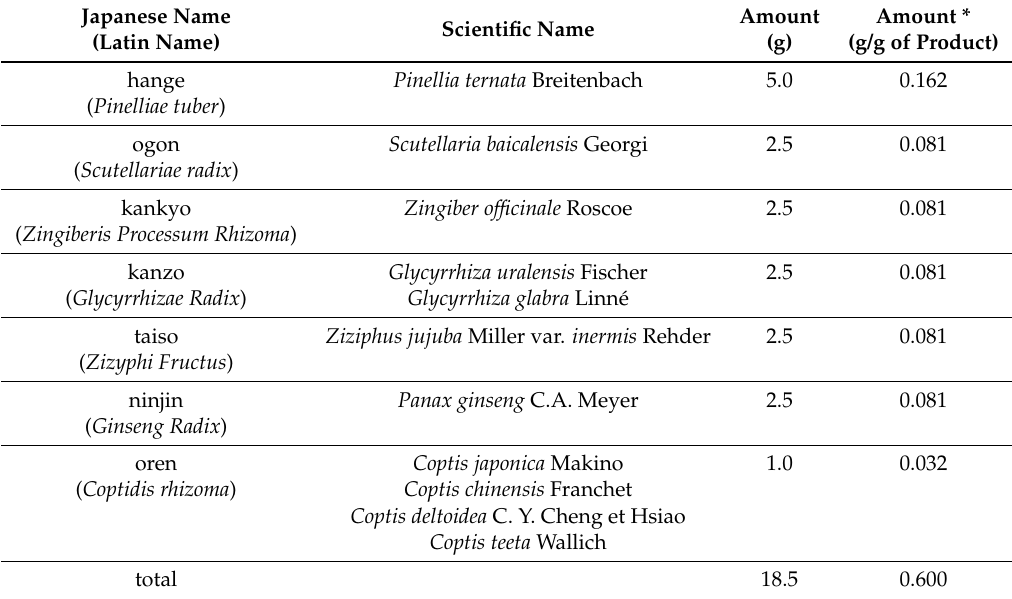
Table 4. The ingredients in the hangeshashinto (TJ-14) formula.